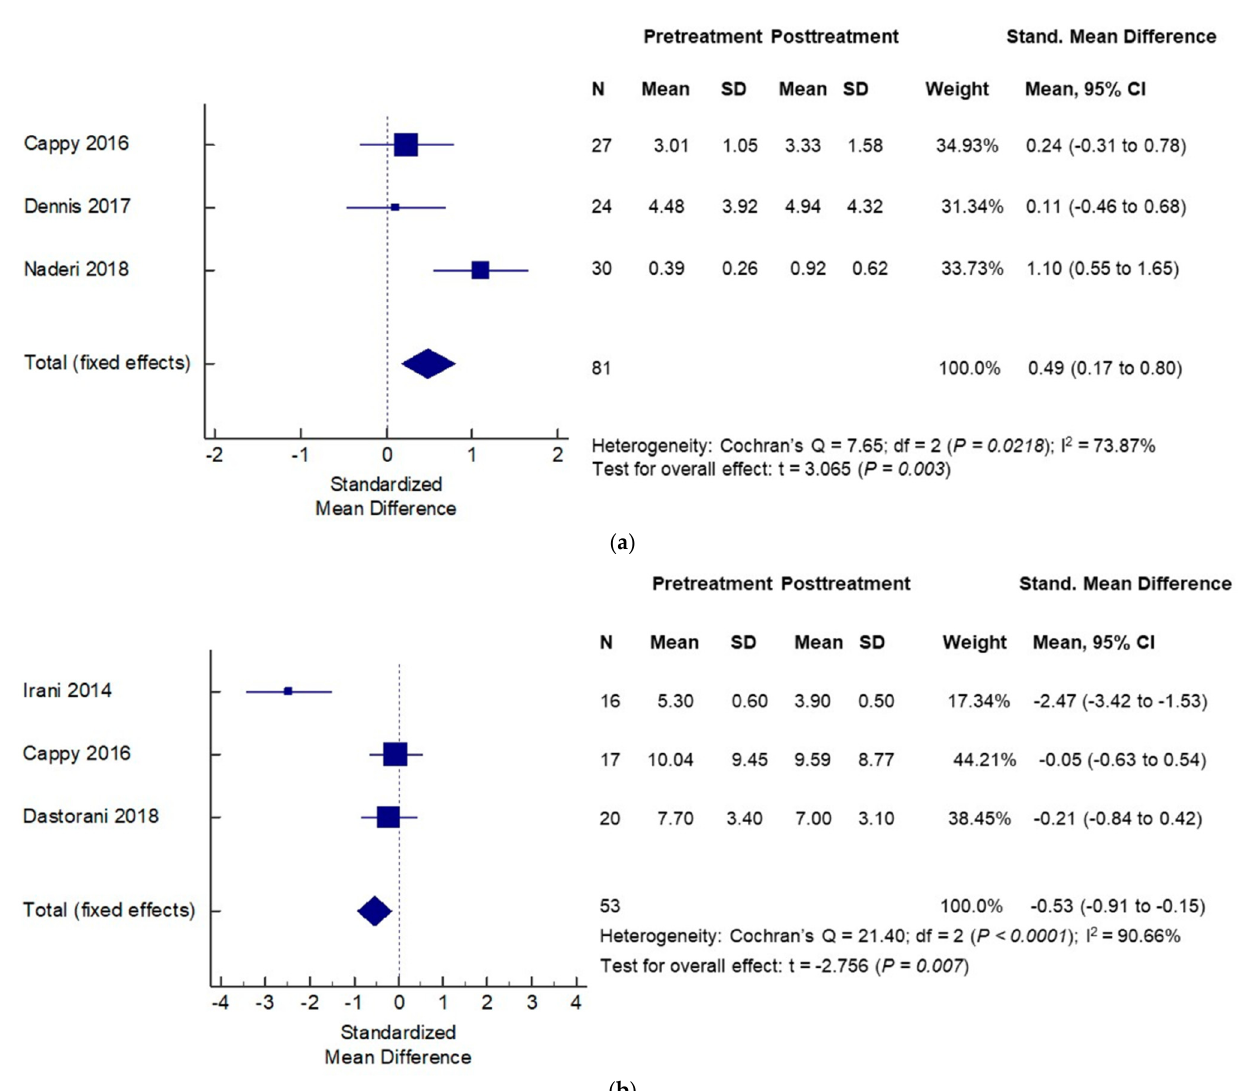
Figure 4. Effects of vitamin D supplementation on serum anti-mullerian hormone (AMH) levels differ by PCOS status: effects seen in non-PCOS ( a ) and PCOS ( b ) populations . Adapted from Mordi et al. [73] .